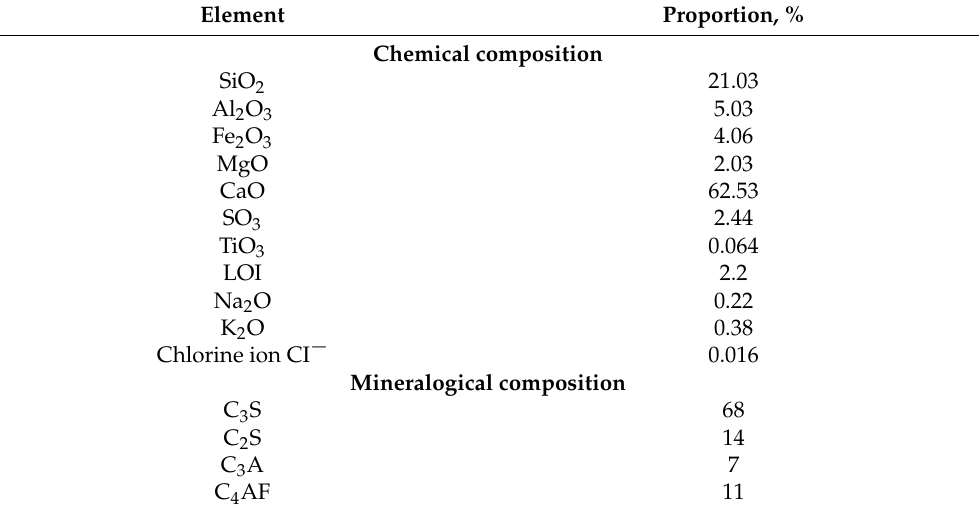
Table 2. Chemical and mineralogical compositions of cement.